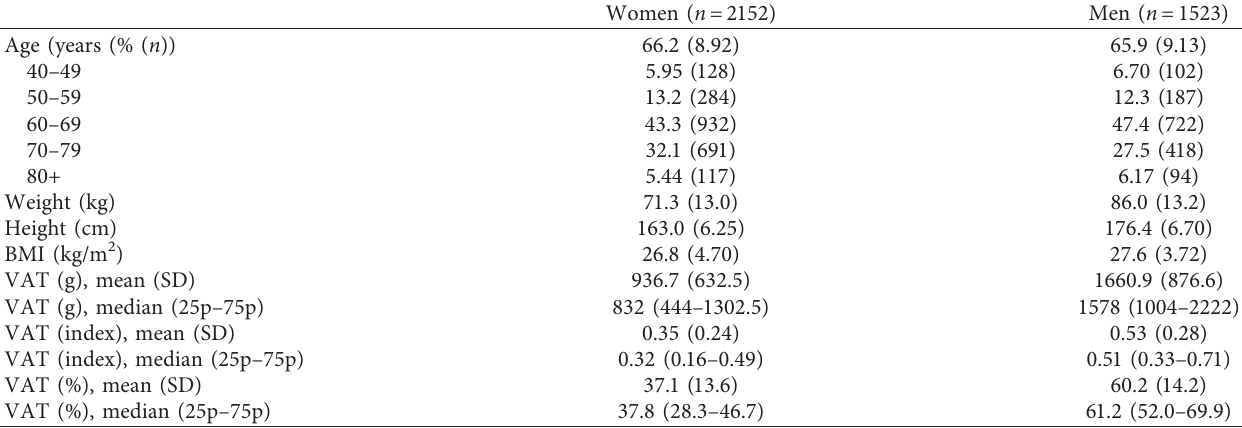
Table 1: Descriptive of study population attending dual energy X-ray absorptiometry: the Tromsø Study